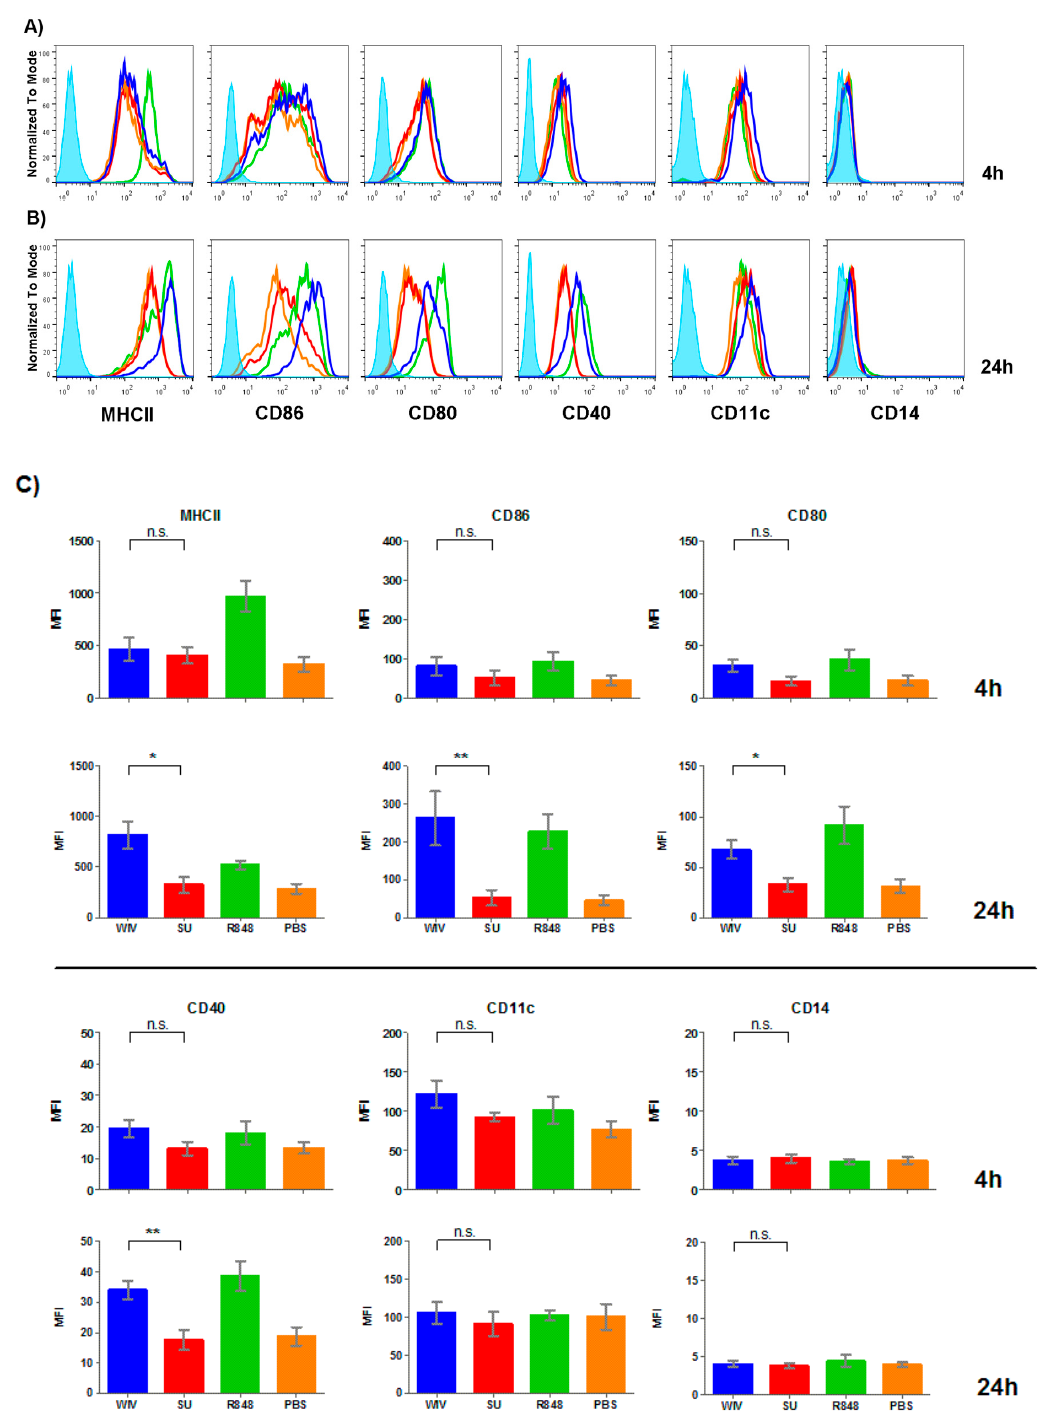
Figure 2. Monocyte-derived dendritic cells (Mo-DCs) show a different surface marker profile when stimulated with different vaccines. Immature DCs were stimulated for 4 h ( A ) and 24 h ( B ) with whole inactivated virus (WIV; blue), subunit (SU; red), R848 (green) or mock-stimulated with PBS (orange). Blue filled peaks represent isotype controls. Subsequently cells were analyzed by flow cytometry for the expression of maturation and activation markers. Histograms correspond to one representative donor ( n = 4); ( C ) Bar graphs depicting mean fluorescent intensities (MFIs) and standard deviations for the different surface and activation markers; n = 4. Levels of significance: not significant (n.s.): p > 0.05; *: p ≤ 0.05; and **: p ≤ 0.01.